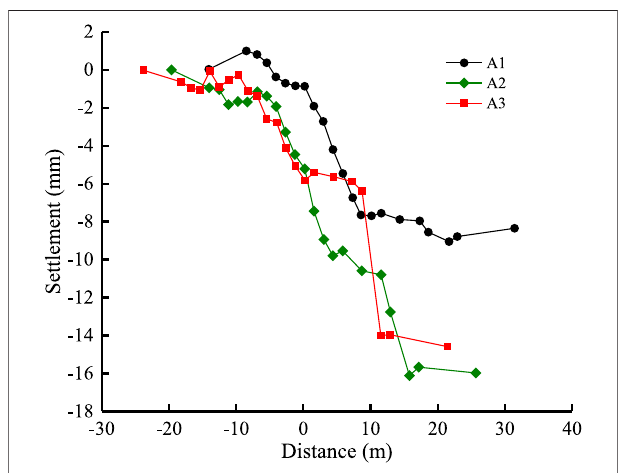
FIGURE 8 | Surface settlement along the direction of tunnel at different burial